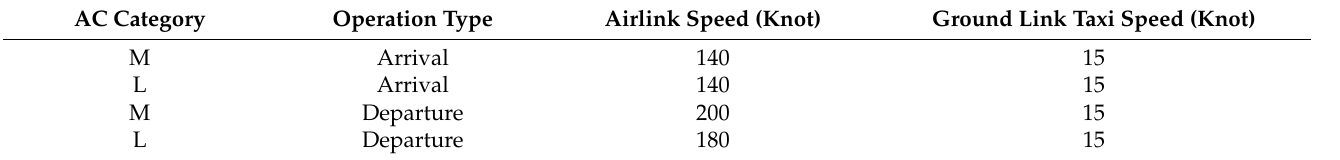
Table 2. Nominal aircraft speeds [42].